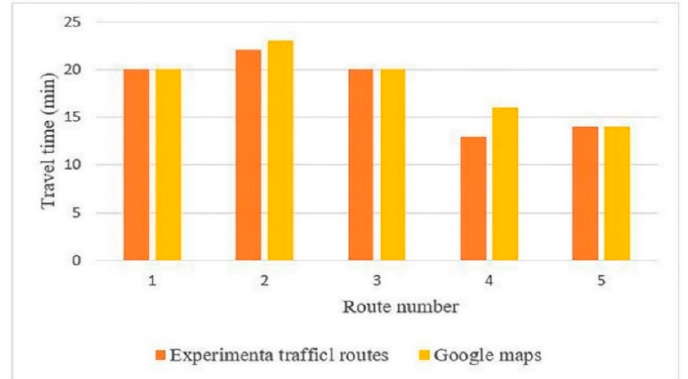
Figure 12. Comparison of route length for the proposed algorithm and Google Maps at off-peak traffic times.